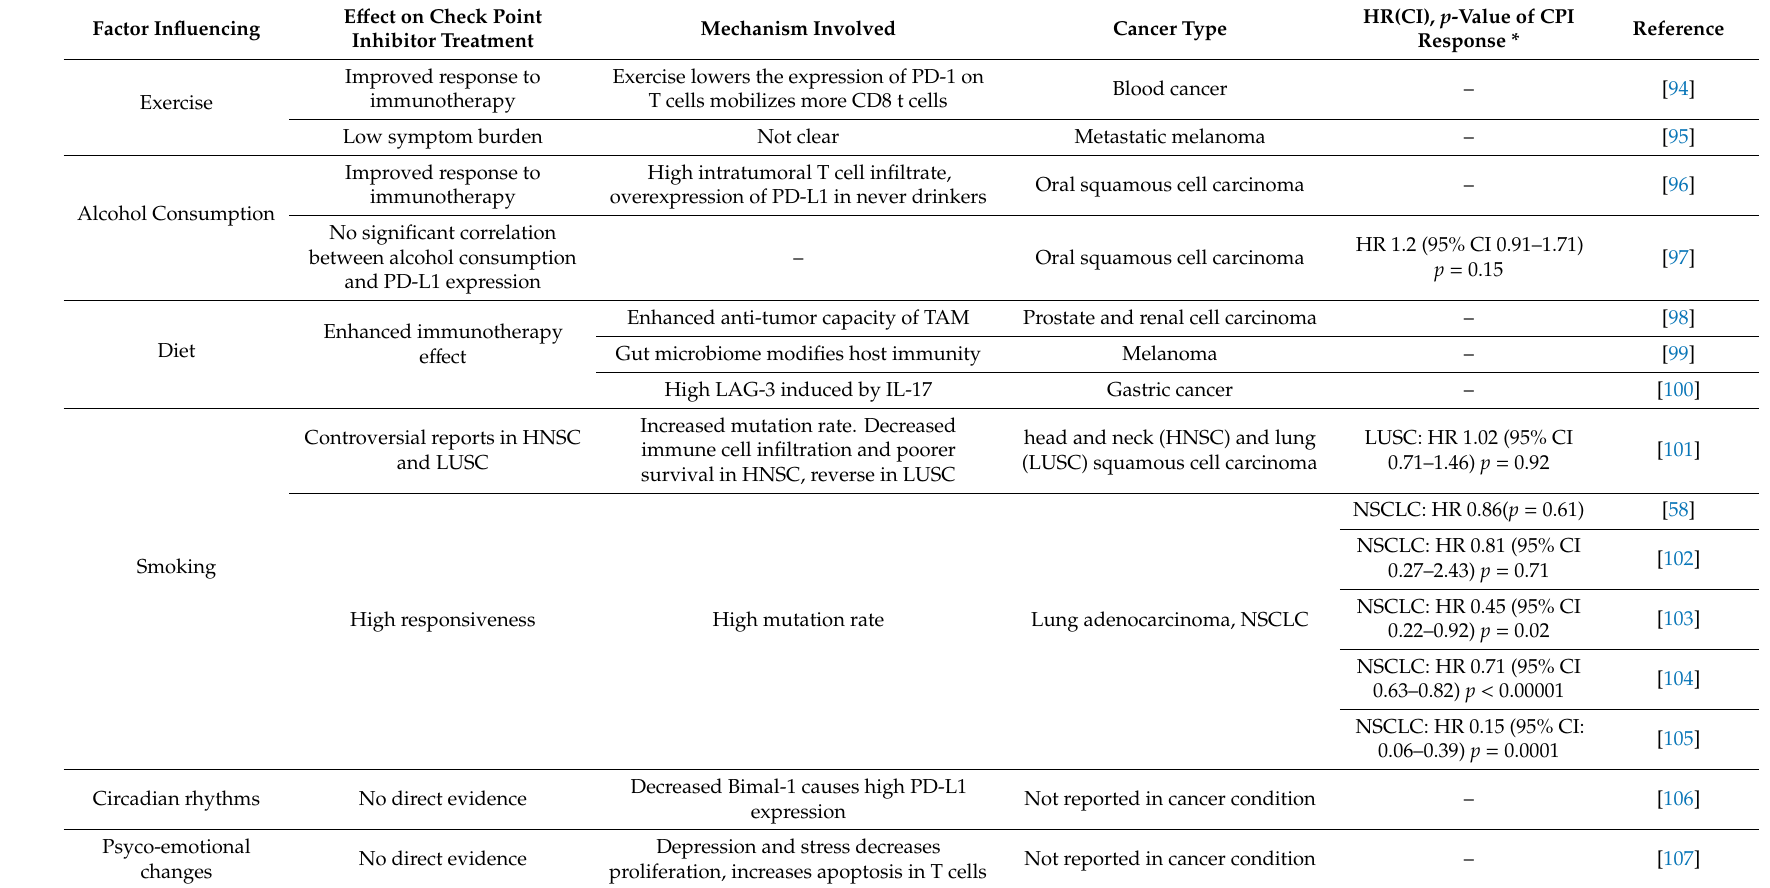
Table 3. Influence of lifestyle changes on CPI